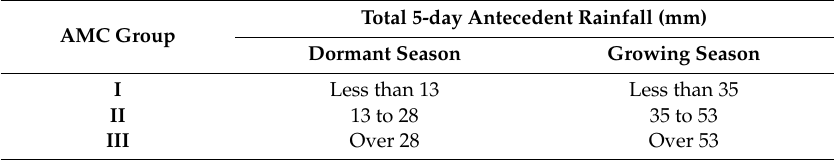
Table 2. Classification of antecedent moisture classes (AMC) for the Soil Conservation Service